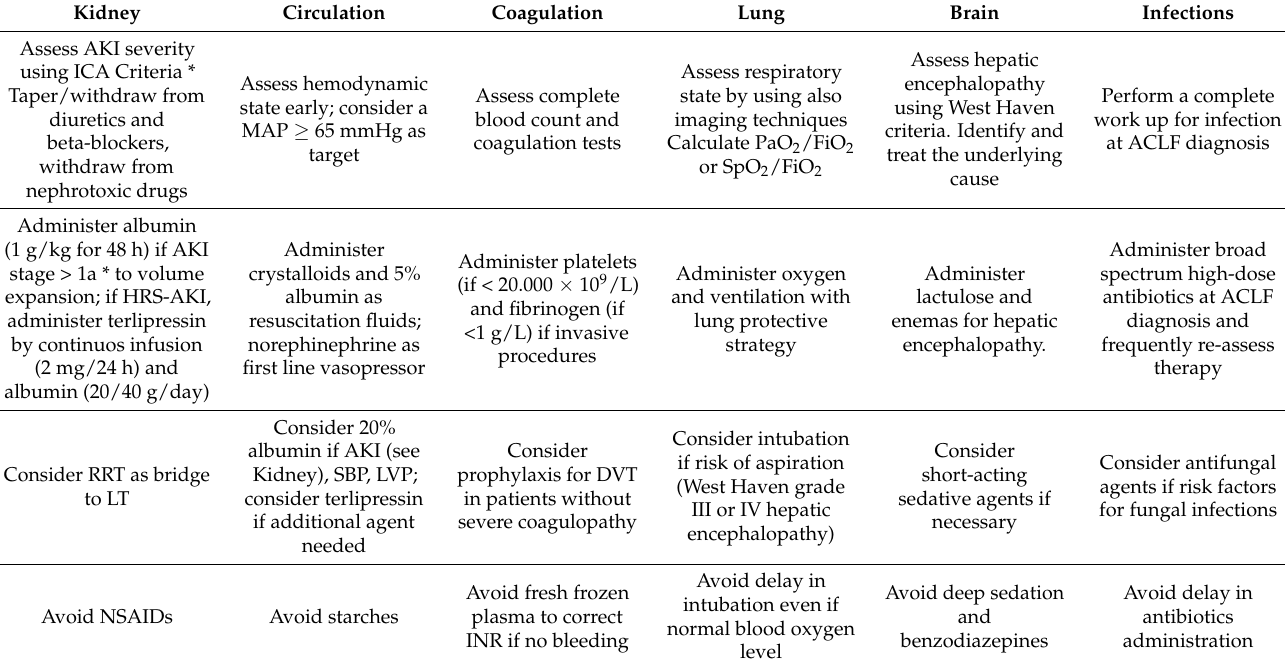
Table 2. Principles of treatment of ACLF [3]. ICA, International Club of Ascites; AKI, acute kidney injury; HRS, hepatorenal syndrome; RRT, renal replacement therapy; LT, liver transplantation; NSAID, non-steroidal anti-inflammatory drugs; MAP, mean arterial pressure; SBP, spontaneous bacterial peritonitis; LVP, large volume paracentesis; DVT deep-vein thrombosis; PaO 2 FiO 2 SpO 2 ACLF, acute-on-chronic liver